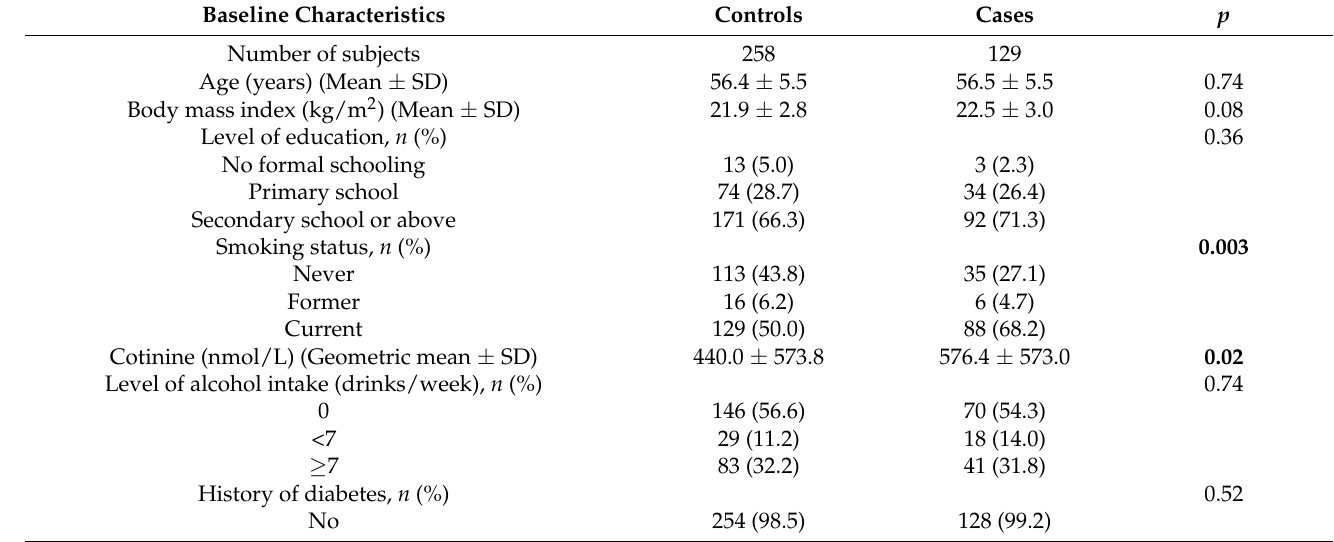
Table 1. Baseline demographic characteristics and lifestyle factors of pancreatic cancer cases and control subjects in the Shanghai Cohort